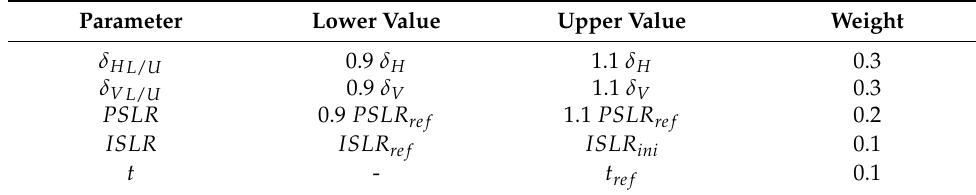
Table 2. Optimization parameters.